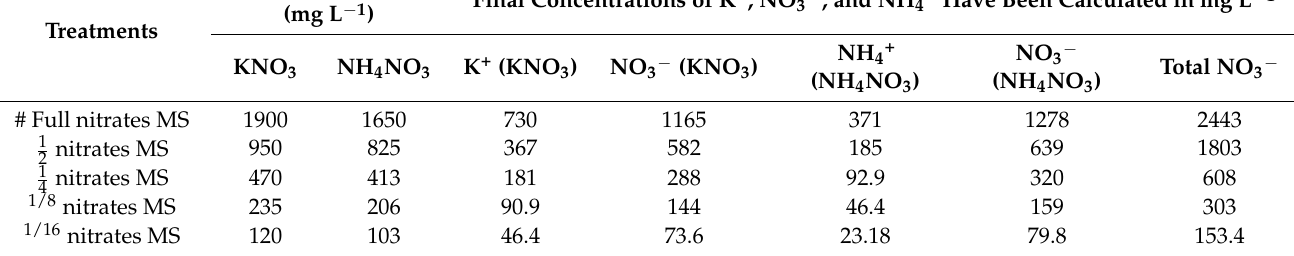
Table 1. Potassium and ammonium nitrate salts concentration in MS